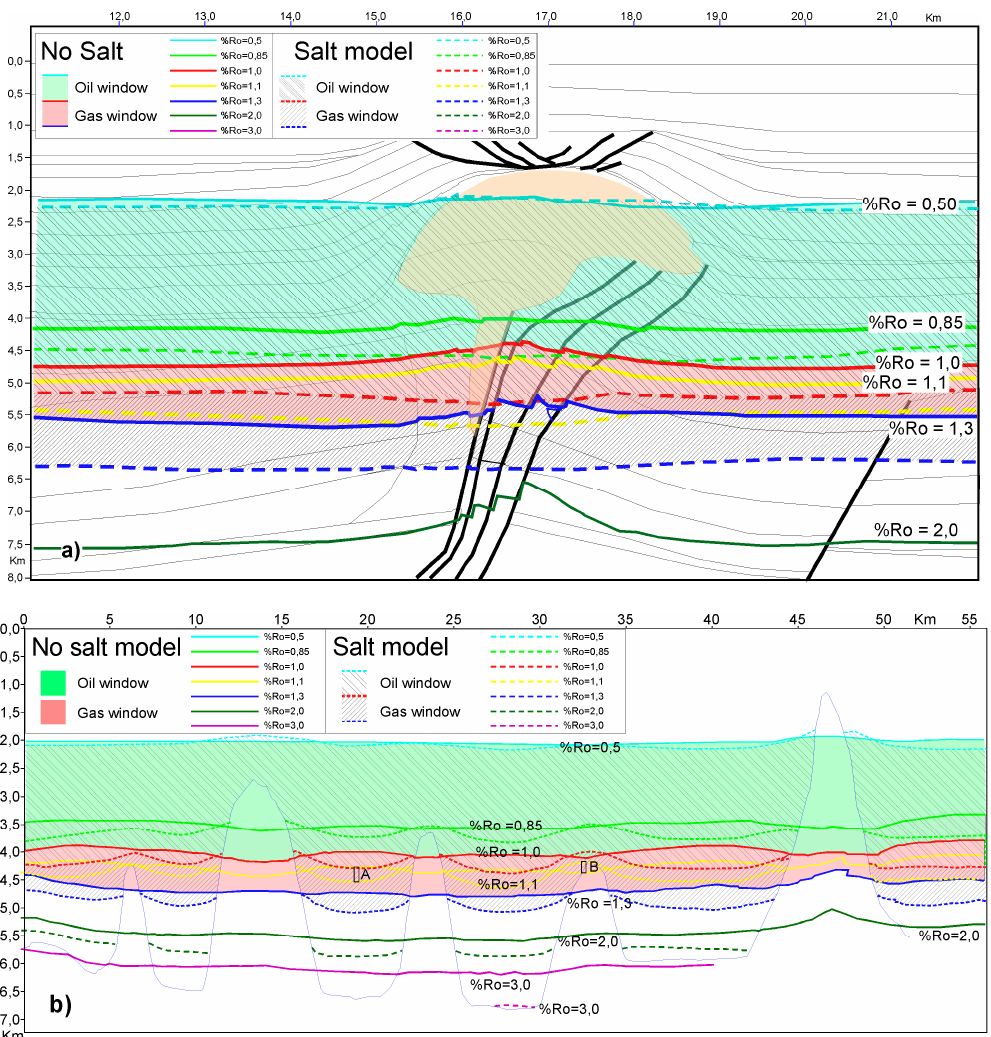
Figure 21. Differences in modeled Vitrinite Reflectance at present day geometry between models with salt (stippled lines) and model without salt diapirs (solid lines). “Oil-window” and “gas-windows” are indicated between %Ro values of 0.5–1.0 and 1.0–1.3, respectively. ( a ) model 1, ( b ) model